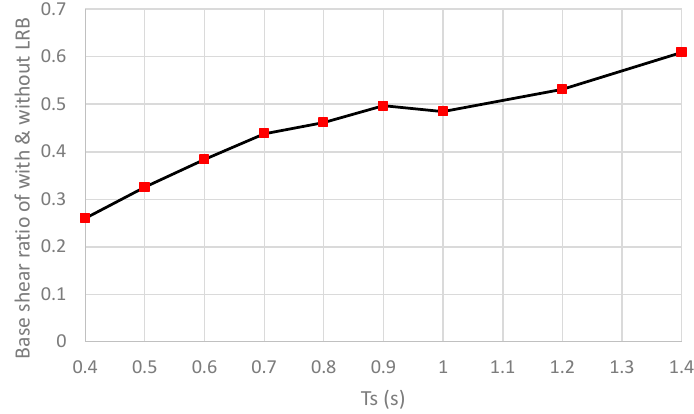
Figure 9. The base shear ratio changing with T s under the PGA of 0.32 g.